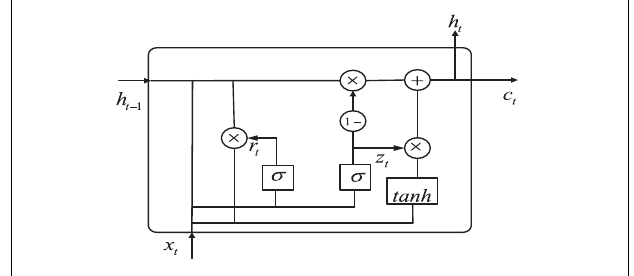
FIGURE 3 | The structure of gate recurrent unit (GRU).